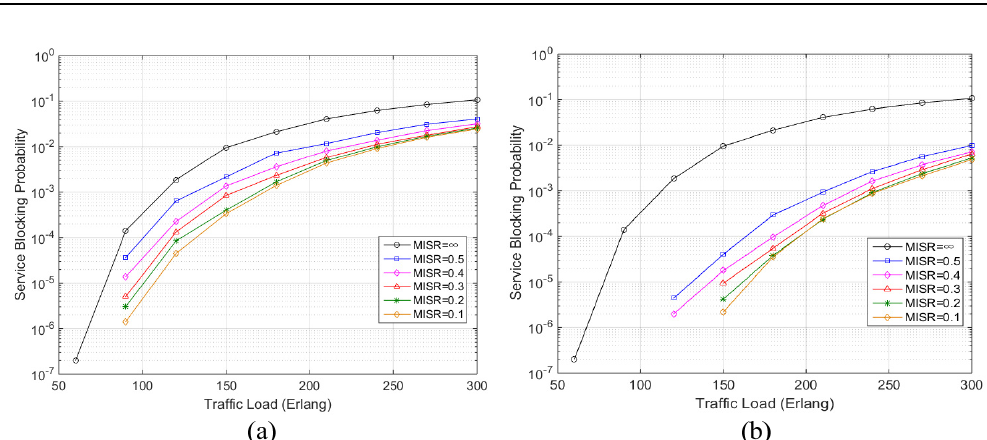
proposed AR-ISR algorithm (with no spectrum defragmentation) gains an obvious advantage over the classic distance-adaptive algorithm in increasing the spectrum alignment rate, especially with a high traffic load, as shown in Figure 4a. For instance, when the traffic is as low as 90 Erlang, the proposed AR-ISR algorithm (with no spectrum defragmentation) can enhance the spectrum alignment rate by 5.34% compared to the distance-adaptive algorithm, with the MISR being set as 0.5. Such an improvement in the spectrum alignment rate reaches 72.7% with the MISR being set as 0.1. When the traffic load reaches as high as 300 Erlang, the proposed AR-ISR algorithm (with no spectrum defragmentation) can increase the spectrum alignment rate by 196.77% compared to the distance-adaptive algorithm, with the MISR being set as 0.5. Such an improvement in spectrum alignment rate reaches 528.67% with the MISR being set as 0.1. All the simulation results indicate that the proposed AR-ISR algorithm can effectively improve the spectrum alignment rate by reducing the invalid spectrum resources even without spectrum defragmentation, especially with a high traffic load. The higher improvement in spectrum alignment rate with a higher traffic load can